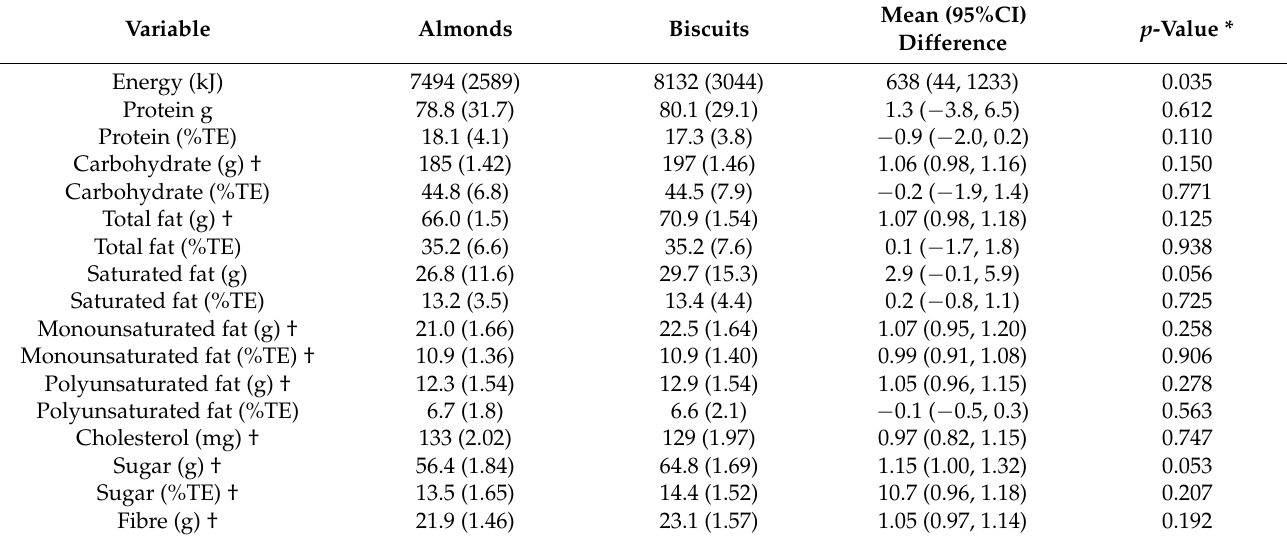
Table 4. Mean (SD) energy and nutrient intakes for the ad libitum lunch and for the remainder of the testing day combined.